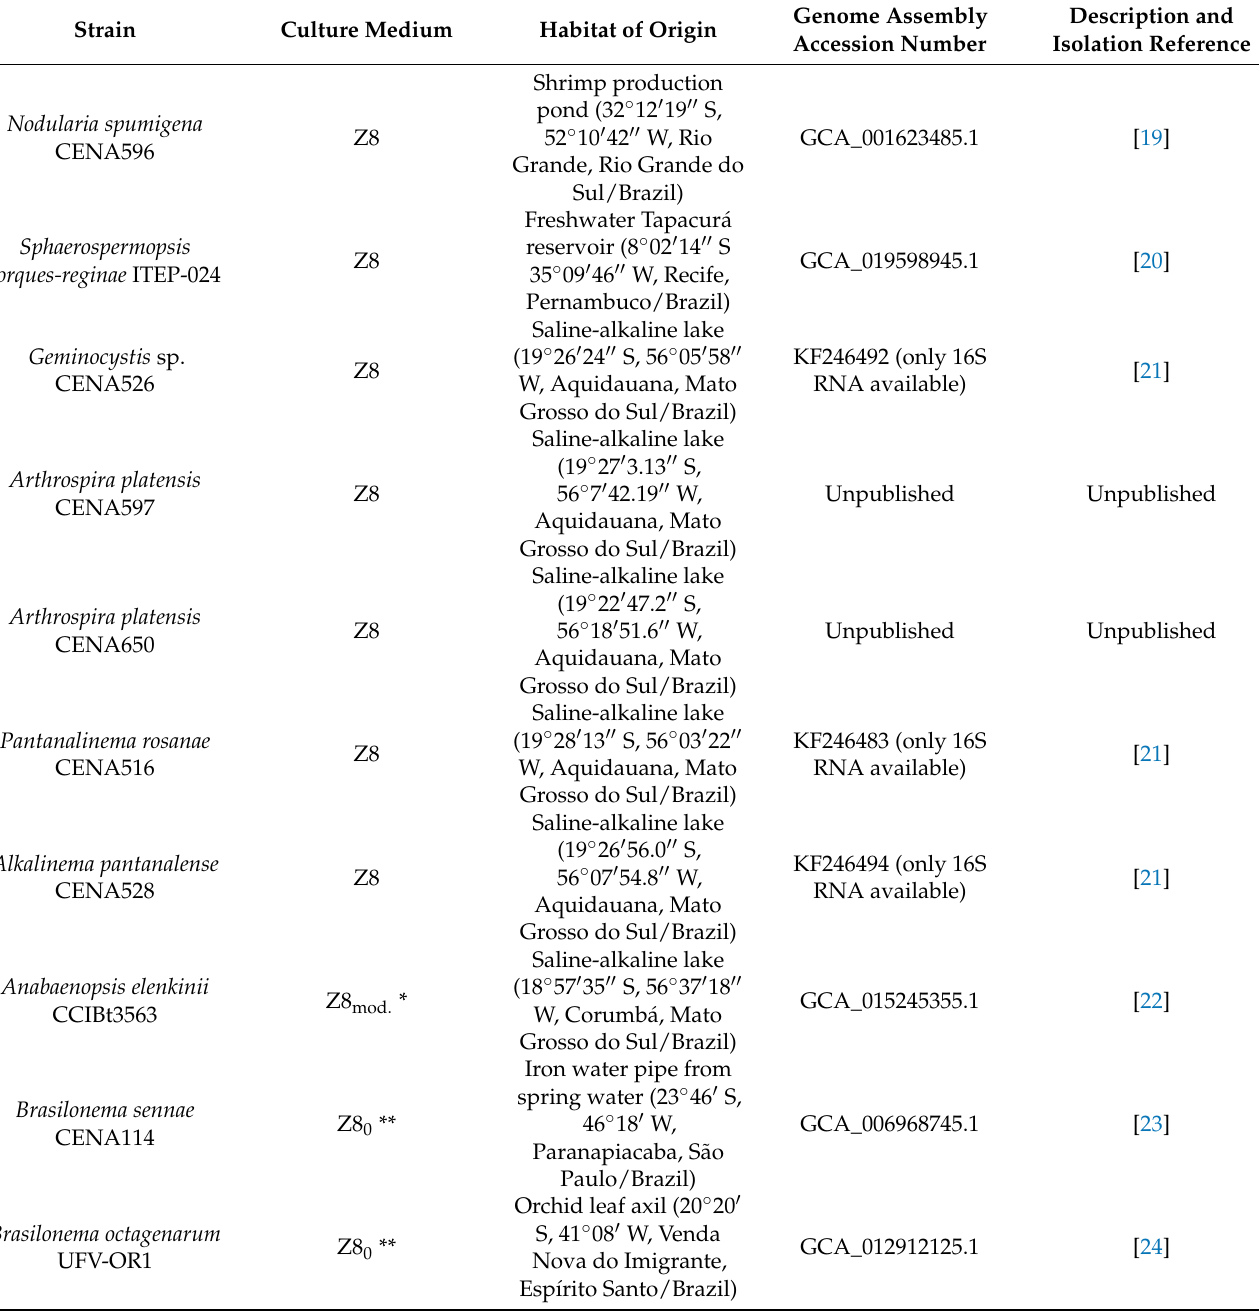
Table 3. Description and isolation details of each strain used in this